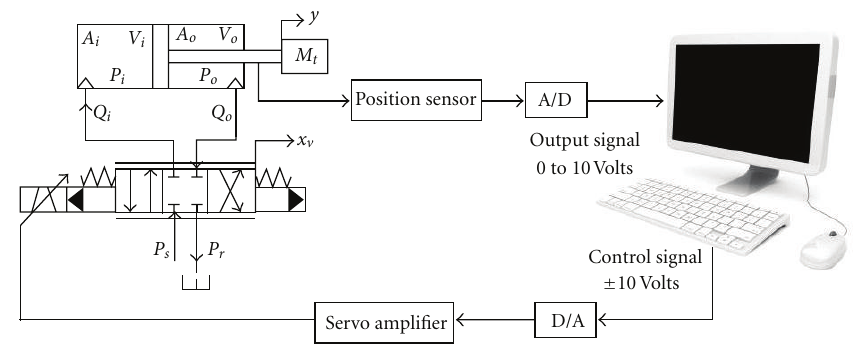
Figure 1: Electrohydraulic actuator